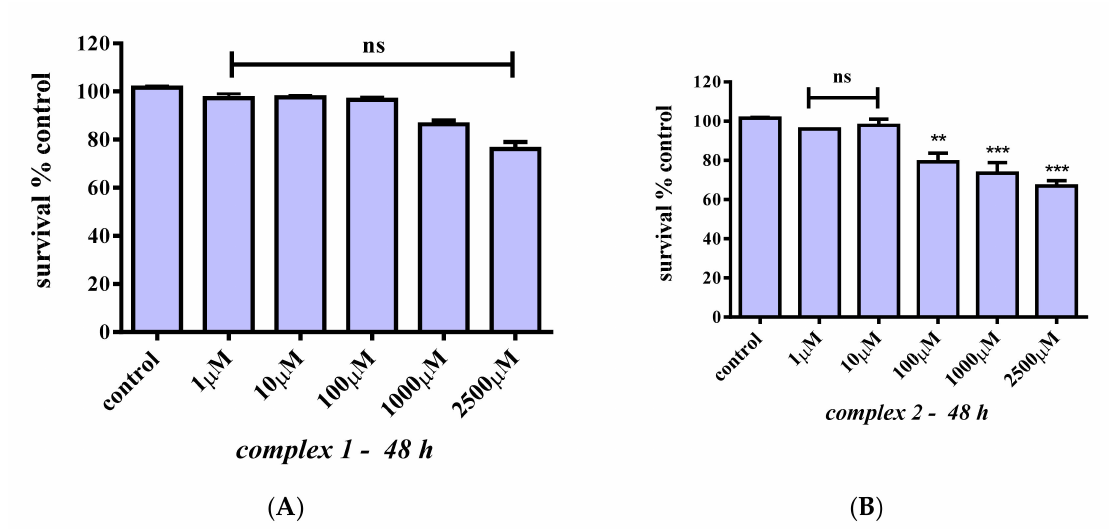
Figure 7. Percent change of cell survival in C2C12 myoblasts, following treatment at various concen- trations (1–2500 µ M) of 1 ( A ) and 2 ( B ) for 48 h. Values represent the mean value of several (n = 3) independent experiments. Vertical bars represent SEMs. **: p < 0.01; ***: p < 0.001 vs. control. ns: not statistically significant ( p >